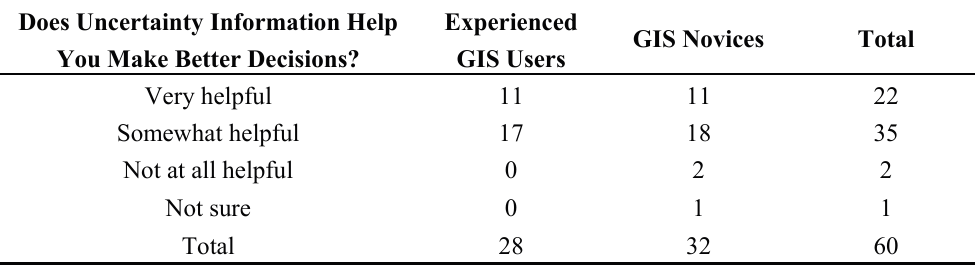
Table 3. Observed frequencies on the helpfulness of uncertainty information for decision making.